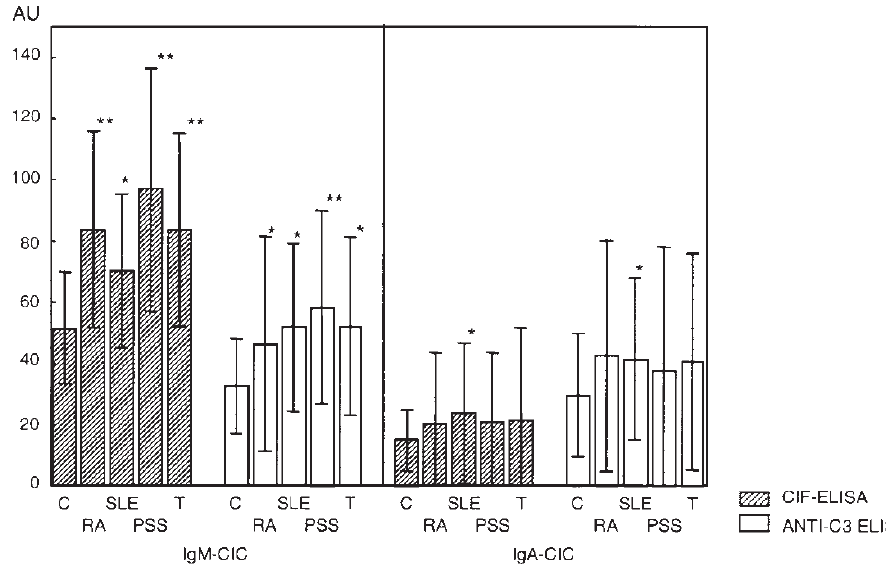
FIGURE 1 Mean and standard deviation values of IgM containing CIC and IgA containing CIC in control and patient groups detected by CIF-ELISA and ANTI-C3 ELISA. The data are presented in AU. With * and ** are presented statistically significant differences ( p , 0.05, and p , 0.01, respectively) between control and patient groups. C- control group; T -